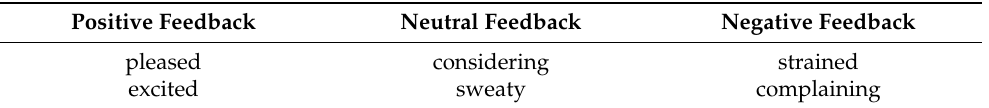
Table 2. Participants’ feeling states.